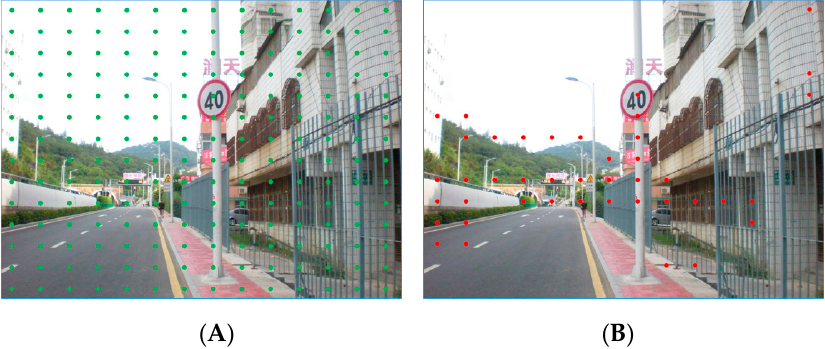
Figure 18. Example of anchors points of the Faster R-CNN without and with HP-RPN. ( A ) anchor points of original Faster R-CNN, ( B ) anchor points of our method.